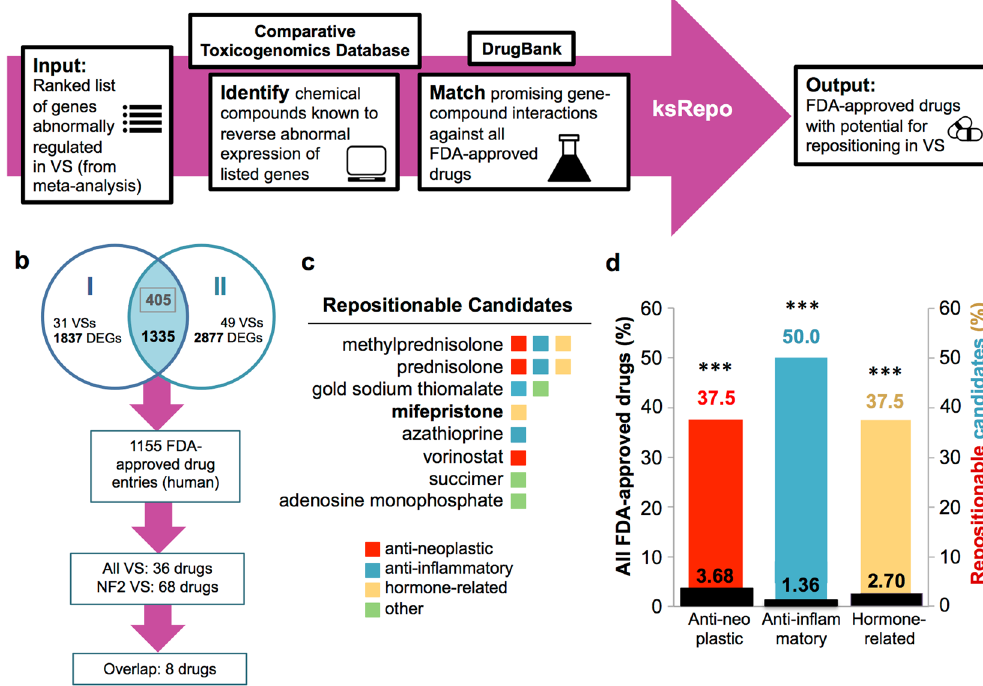
Figure 1. Computational repositioning of FDA-approved drugs using ksRepo. ( a ) ksRepo workflow schematic. ( b ) Largest meta-analysis to date of genome-wide expression in VS (n = 80 tumors), yielding 1,335 commonly dysregulated genes, 405 of which are significantly differentially expressed after Bonferroni correction (p < 0.05); ksRepo recommends 8 drugs with high potential for repositioning in sporadic and NF2-associated VS. ( c ) Drug classes of repositionable candidates from ksRepo analysis. ( d ) Significant enrichment of anti-inflammatory, anti-neoplastic, and hormone-related drugs from 1,155 FDA-approved drugs after ksRepo analysis ( *** p < 0.001; black bars, percentage of all drugs in DrugBank that fall within each category; colored bars, percentage of drugs on our ksRepo-recommended shortlist that fall within each